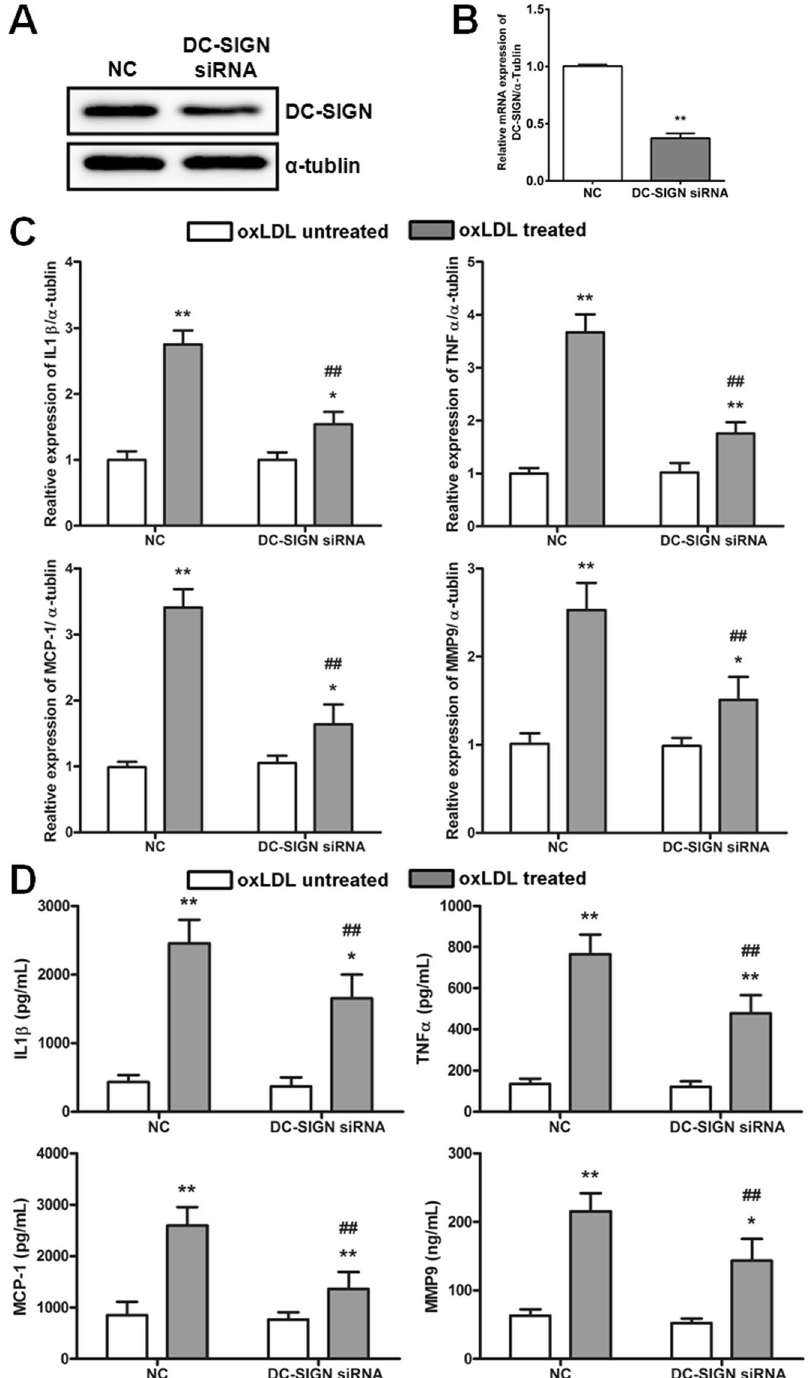
Figure 3. DC-SIGN-regulated inflammatory cytokine expression. DC-SIGN or a negative control (NC) siRNA was transfected into macrophages treated or not treated with oxLDL (50 μ g/ml) for 6 hours. ( A ) The knockdown efficiency of DC-SIGN siRNA was detected by western blot analysis. ( B ) The efficiency of DC-SIGN knockdown was detected by real-time PCR. The data are expressed as the mean ± SD from 3 independent tests. ** P < 0.01 compared with the macrophages transfected with negative control siRNA (NC). ( C ) Real-time PCR detected the expression of IL-1 β , TNF- α , MCP-1 and MMP-9. ( D ) ELISA measured the secretion of IL-1 β , TNF- α , MCP-1 and MMP-9. The data are expressed as the mean ± SD from 3 independent tests. * P < 0.05, ** P < 0.01 compared with macrophages not treated with oxLDL in the same group, ## P < 0.01 compared with the NC in the same